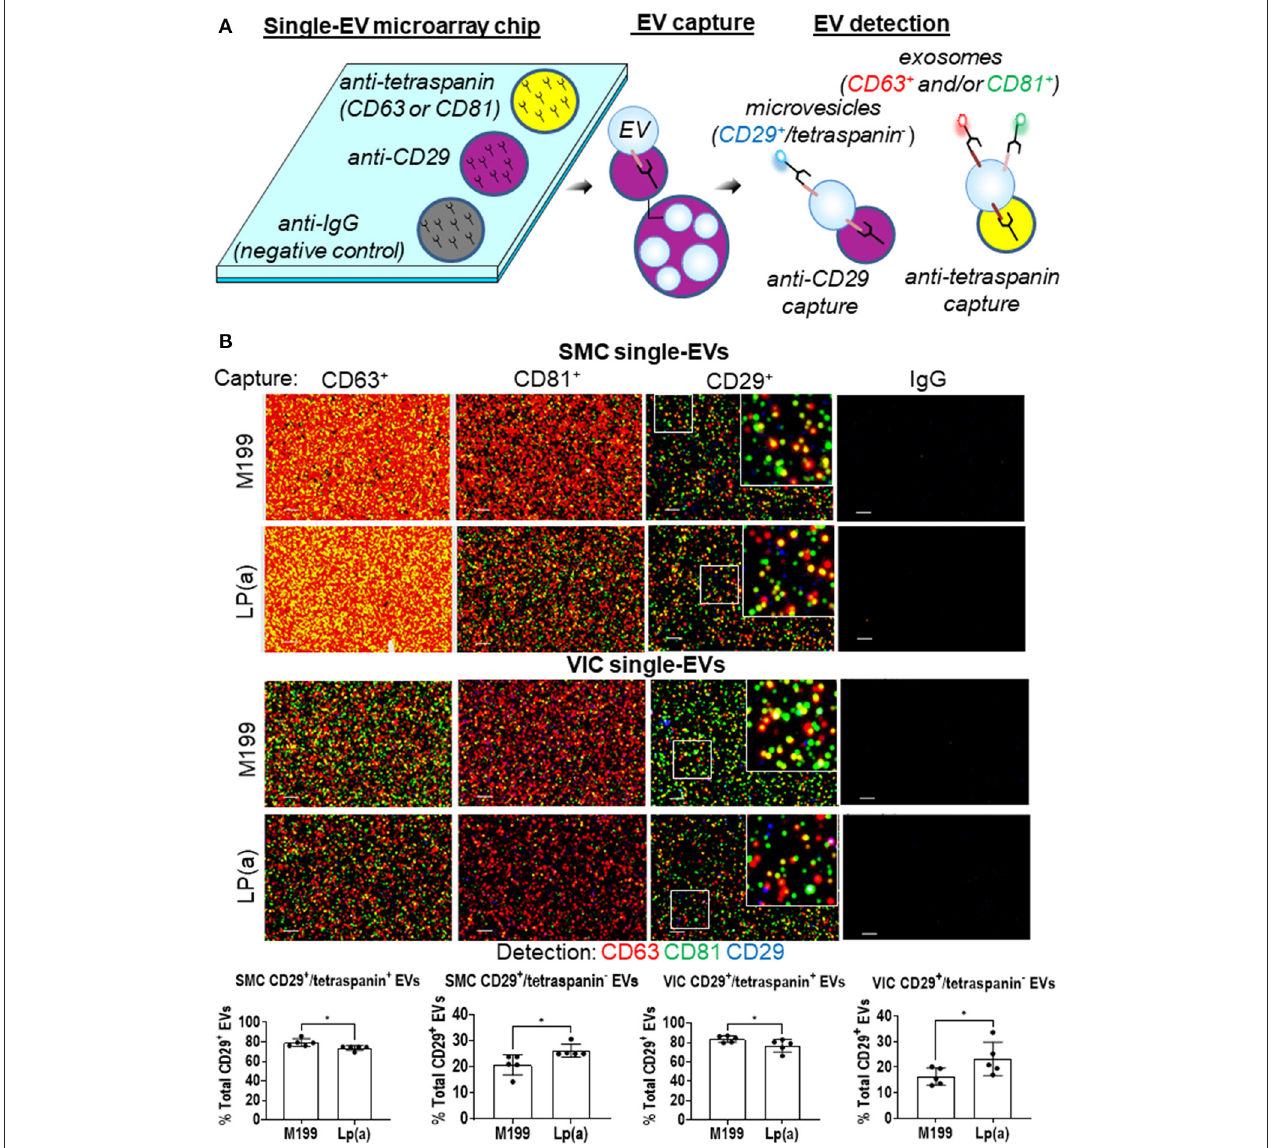
FIGURE 3 | Lp(a) altered EVs composition in calcifying human SMCs and VICs. (A) Cartoon depicting the single-EV microarray assay in which microarray chips printed with anti-CD29, anti-tetraspanins, and negative control IgG capture antibodies are used to capture single EVs that are subsequently detected for additional proteins on captured EVs using fluorescently conjugated antibodies. (B) Example images of single-EVs captured on microarray chips and fluorescently detected with CD63, CD81, and CD29 or IgG negative control antibodies; scale bars = 1 µ m, n = 5 donors. White boxes indicates area of the higher magnification inset images. Quantification of CD29 + /tetraspanin + EVs and CD29 + /tetraspanin − EVs detected using single-EV microarray and conditioned media from SMCs and VICs incubated in control (M199) or calcifying BGP containing media with Lp(a) ( n = 5 donors); analyzed by Welch’s t-test, * P < 0.05, error bars =